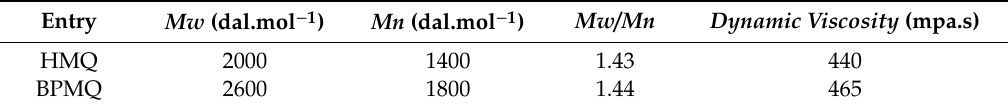
Table 1. The molecular weights and viscosity of HMQ and